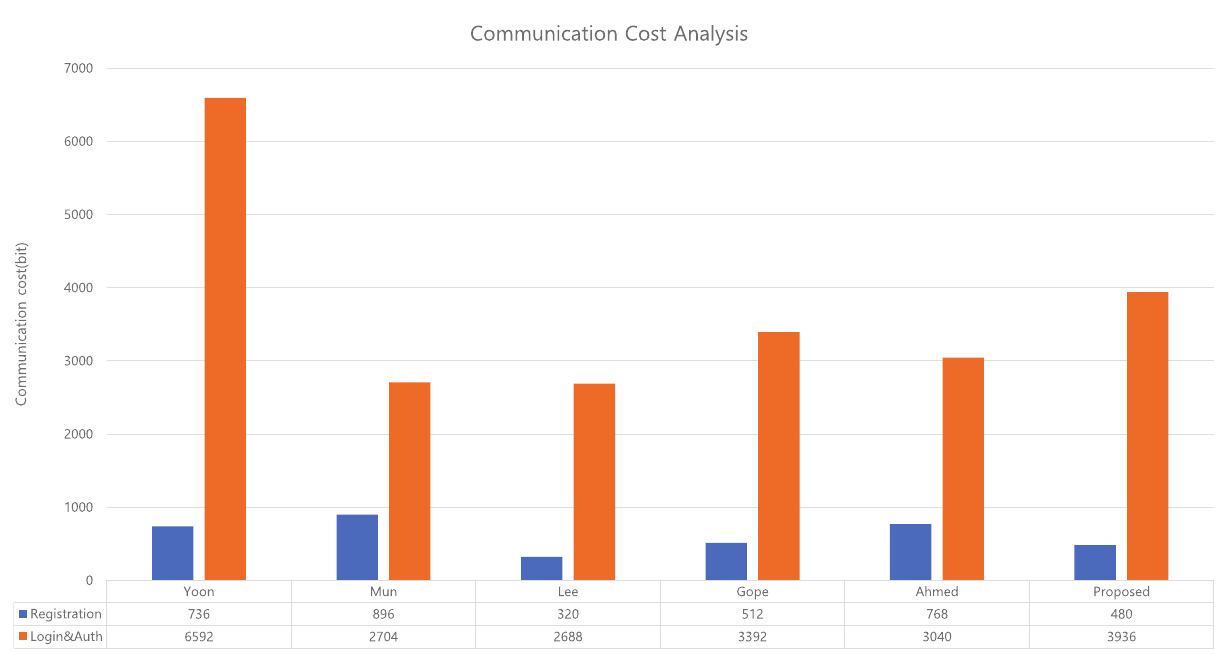
Fig 22. Communication cost analysis between our proposed scheme and existing scheme.